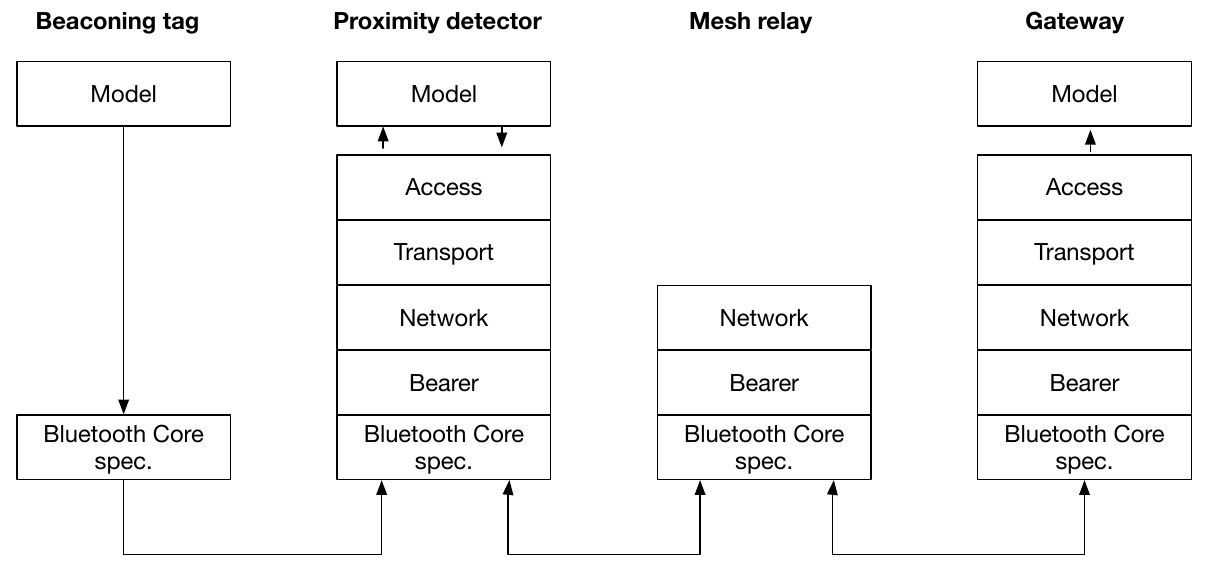
Figure 3. System architecture for the proposed Bluetooth mesh infrastructure for contact